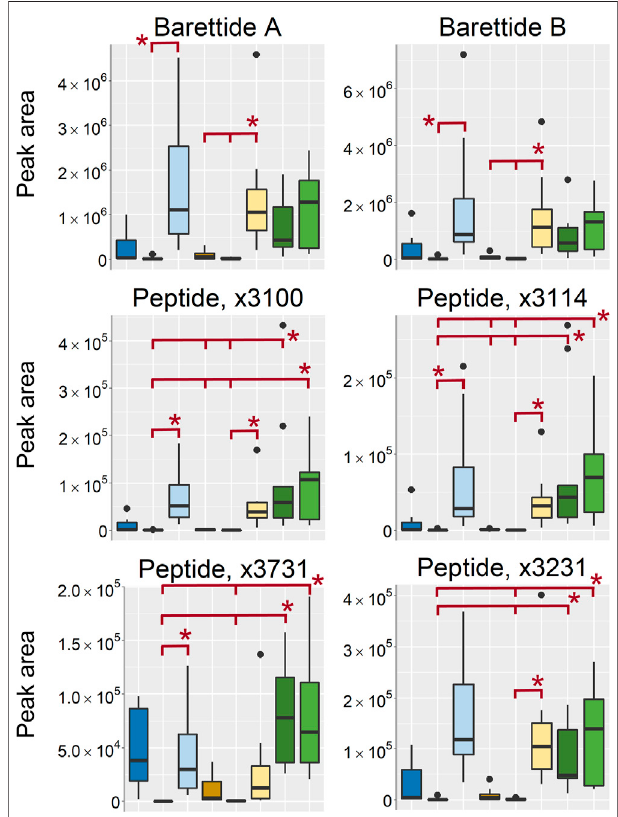
FIGURE 11 | Boxplots of peptides found as differentiating between the sample treatments. All boxplots in the fi gure was based on data from the analysisoforganicextractsinpositiveionizationmode.EtOHextr.1(darkblue ), EtOHextr.2(blue ),EtOHsp.(lightblue ),MeOHextr.1(darkorange ), MeOH extr.2 (yellow ), MeOH sp. (light yellow ), frozen (dark green ), and fl ash frozen (green ). Outliers are denoted as dots in the plots. Statistical signi fi cance ( p < 0.05) is marked by * in therespective box-plots, all p -values from the Kruskal Wallis and Nemenyi post-hoc testing can be found in supplementary data, Supplementary Table S14